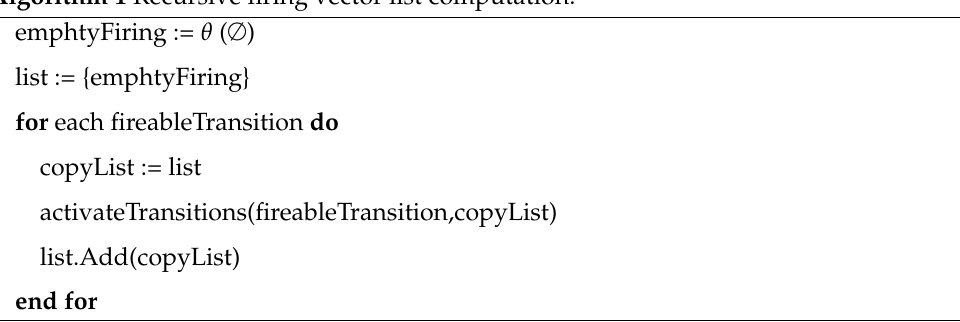
Algorithm 1 Recursive firing vector list